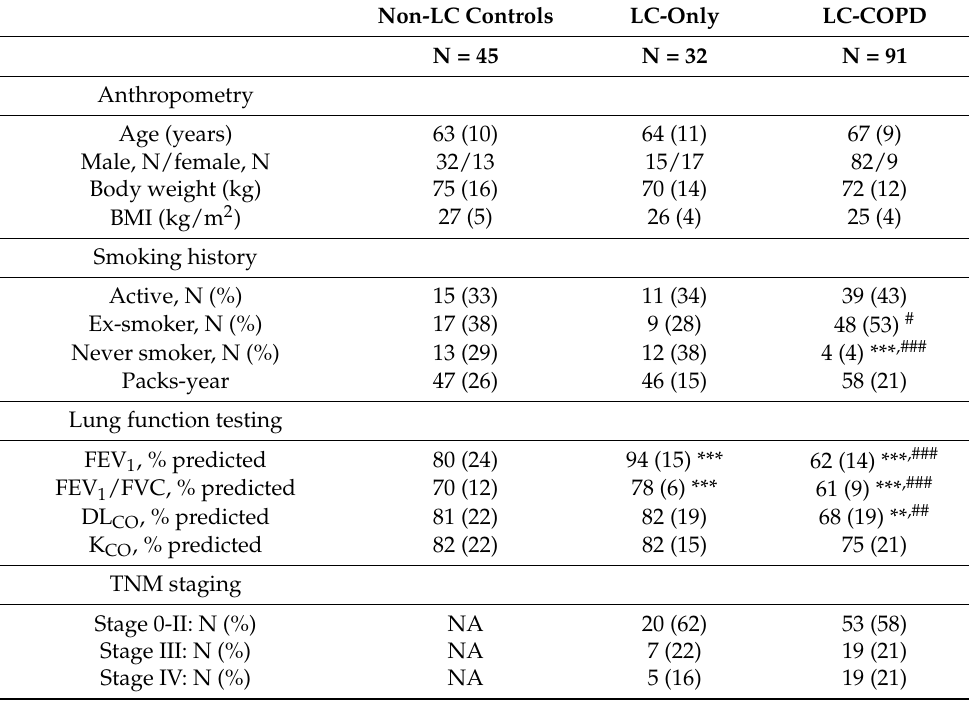
Table 2. Clinical characteristics of the study